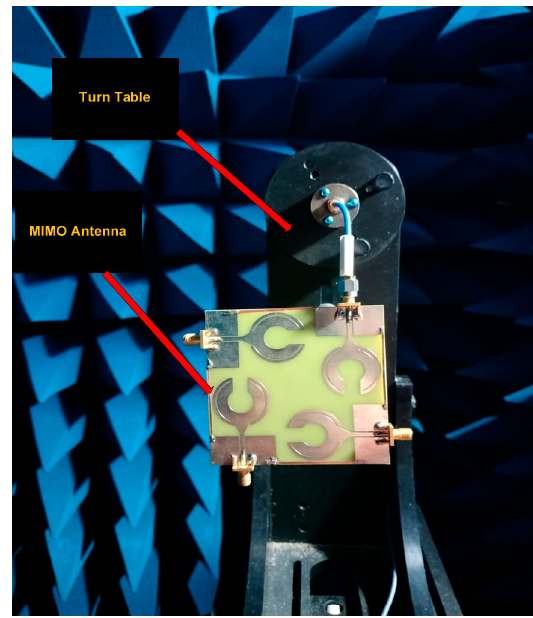
Figure 9. Radiation pattern measurement setup.